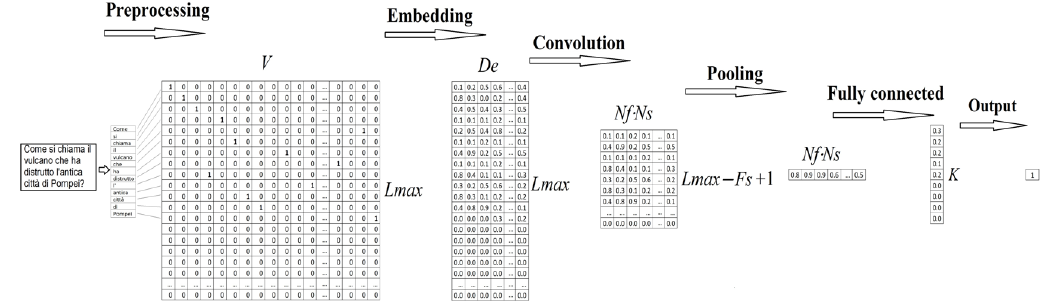
Figure 1. The Question Classification model.